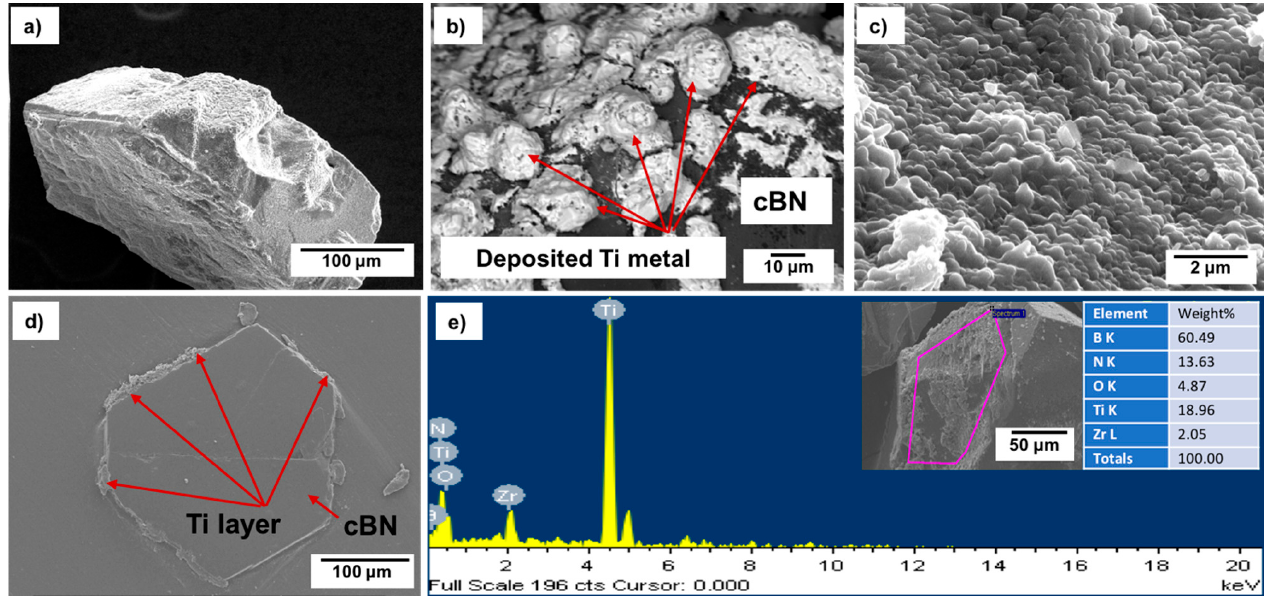
Figure 5. ( a – c ) FESEM images with different magnification, ( d ) cross sectional area and ( e ) EDAX compositional analysis of the Ti ‐ metallized cBN particles.